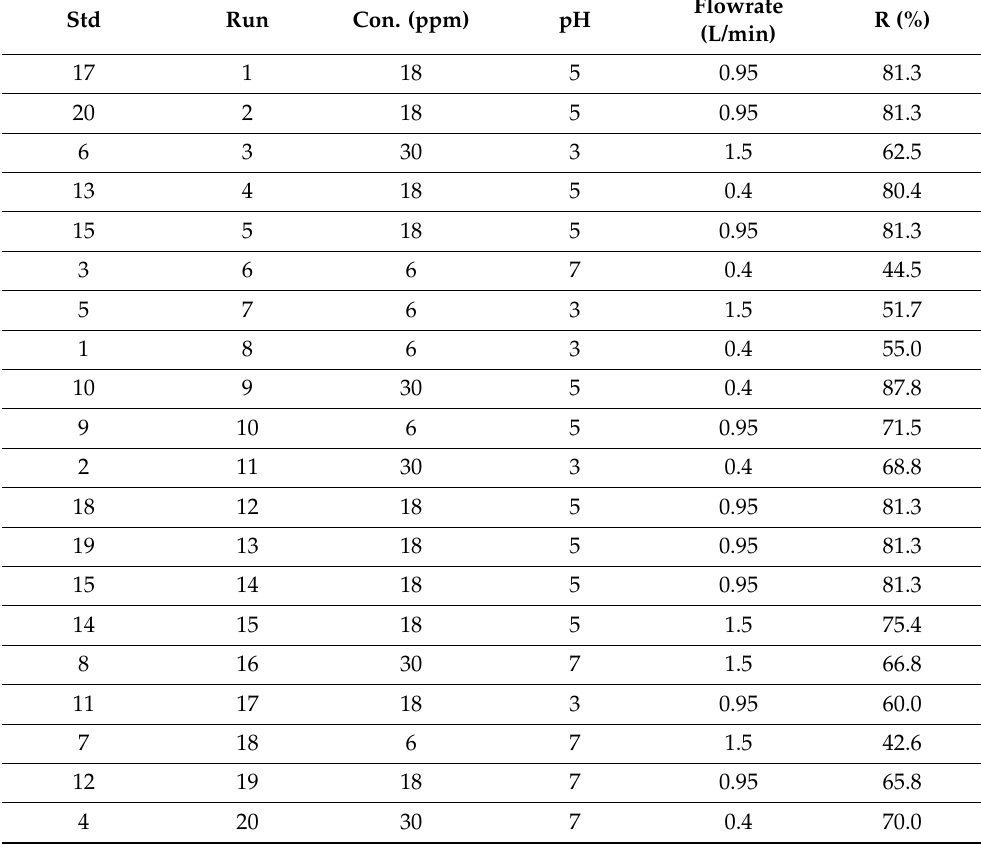
Table 2. Experimental data points and responses used in the CCD.